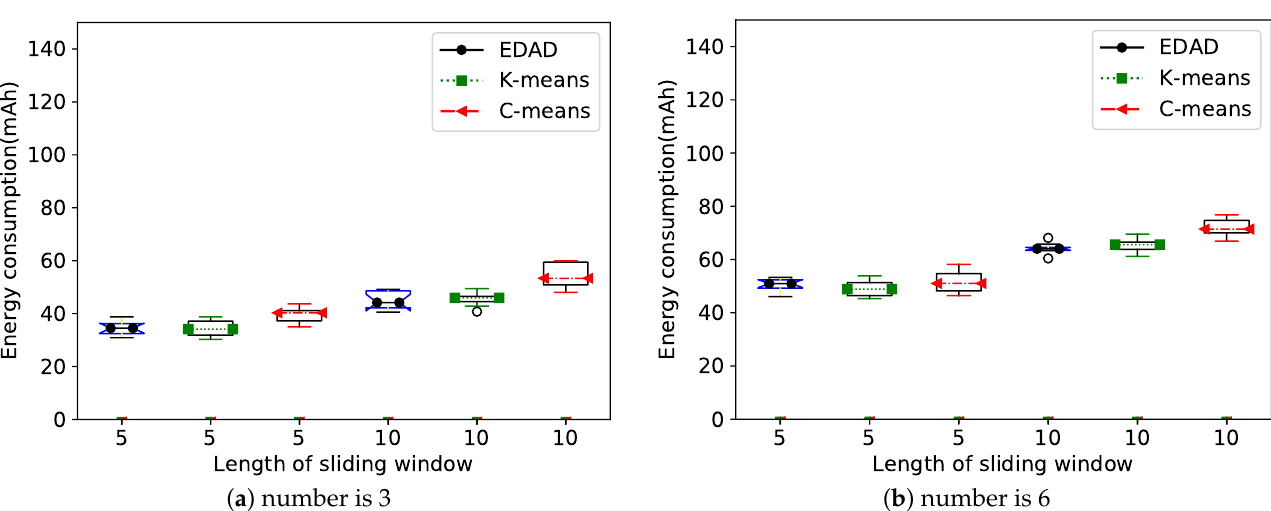
Figure 10. Energy consumption experiment result under different sliding window lengths and different sensor